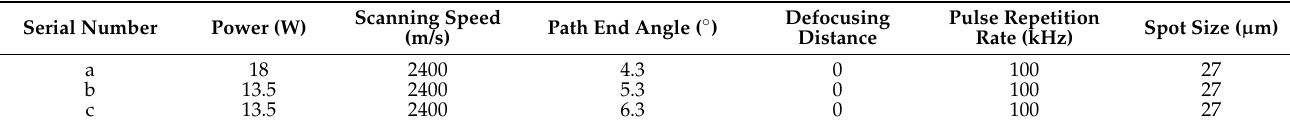
Table 2. Experimental sample and the corresponding processing parameters.